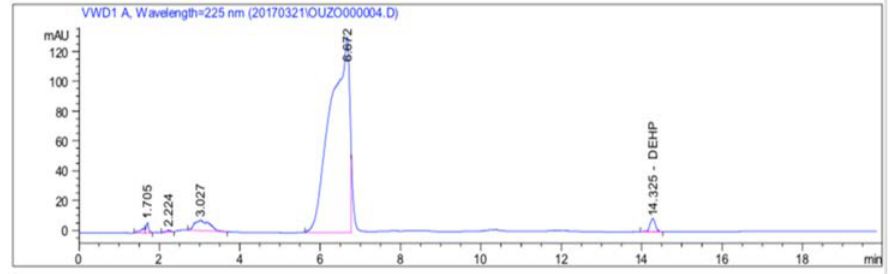
Figure 2. Chromatogram, HPLC, pure ethyl alcohol solvent 40%vol, to check the specificity of the method.